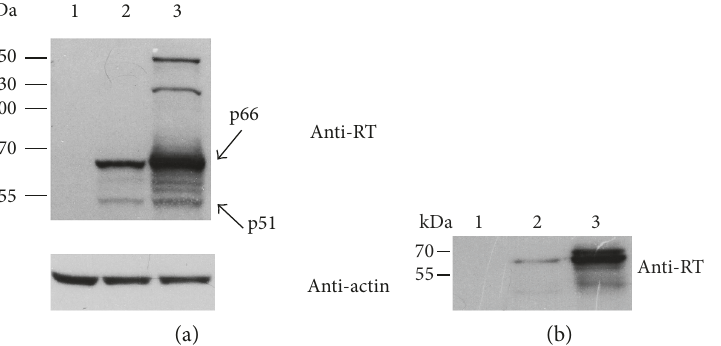
Figure 2: Expression of HIV-1 RT1.14 fused to the N-terminal signal peptide of NS1 protein of TBEV in HeLa cells resolved by SDS-PAGE. (a) Western blotting of the lysates of HeLa cells transfected with pVax1 (1), pVaxRT1.14opt-in (2), and pVaxRT1.14oil (3) plasmids; upper panel, membranes stained with anti-RT; lower panel, with anti- β -actin antibodies for signal normalization. (b) Western blotting of the culture fl uids of cells transfected with pVax1 (1), pVaxRT1.14opt-in (2), and pVaxRT1.14oil (3). Blots were stained with the speci fi c polyclonal anti- RT antibodies as described in the experimental section “ Materials and Methods. ” To control equal loading of the samples of cell lysates on the gel, membranes were for the second time stained with anti- β -actin antibodies. Positions of the molecular mass markers are given to the